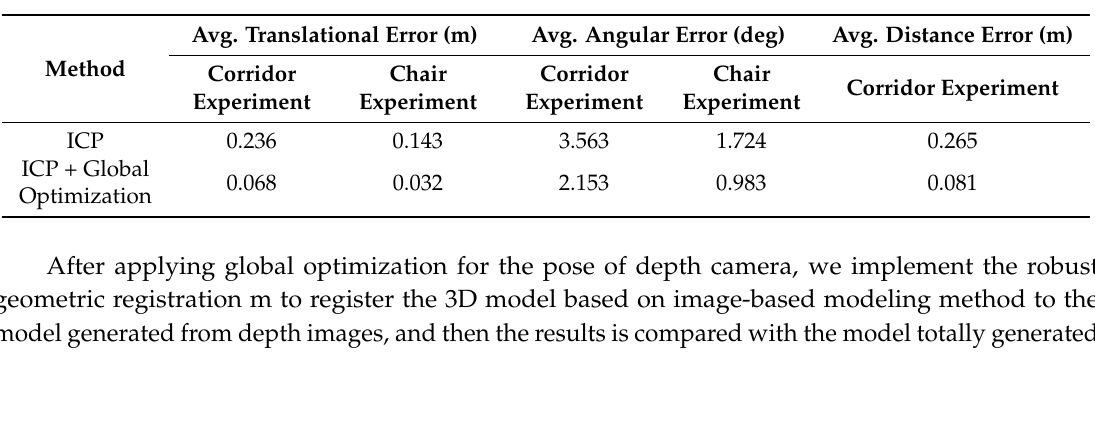
Table 3. Sequential alignment comparison with different